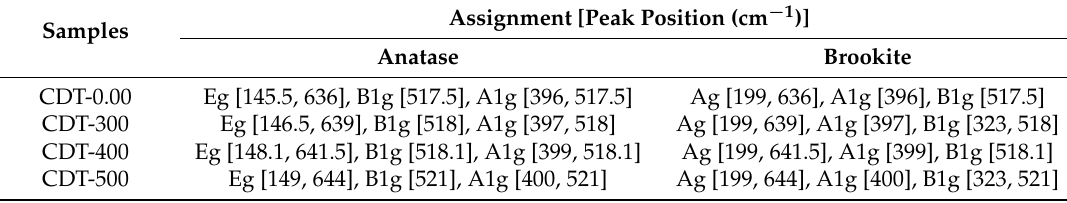
Table 2. Raman vibration bands and their assignments in CDT-0.00, CDT-300, CDT-400, and CDT-500 samples at 532 nm excitation wavelength.